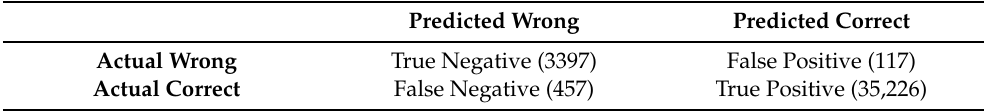
Table 4. Validation confusion matrix.